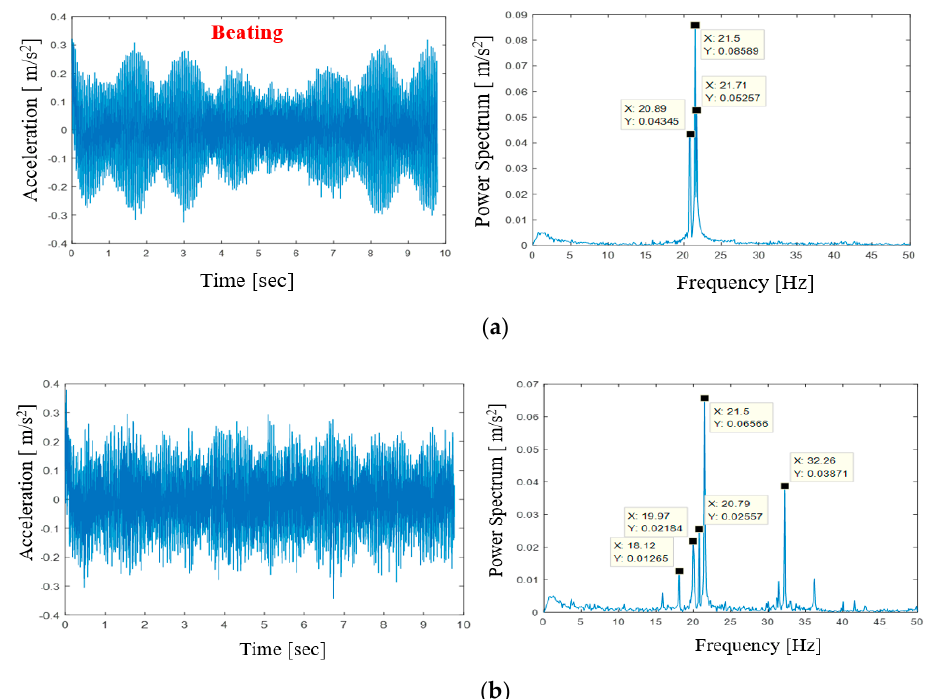
Figure 11. Vibration characteristics before and after adjusting driving frequencies under full facilities operating condition at the plant office: ( a ) Vibration responses at the plant office before adjusting driving frequency; ( b )Vibration responses at the plant office after adjusting driving frequency.